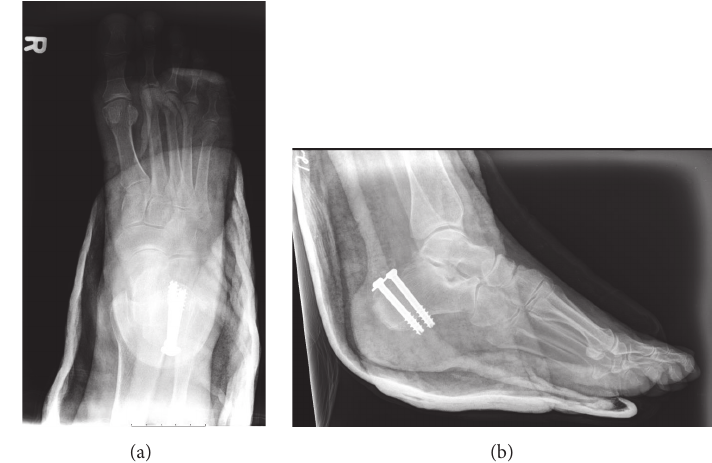
Figure 2: Anteroposterior (a) and lateral (b) radiographs taken immediately